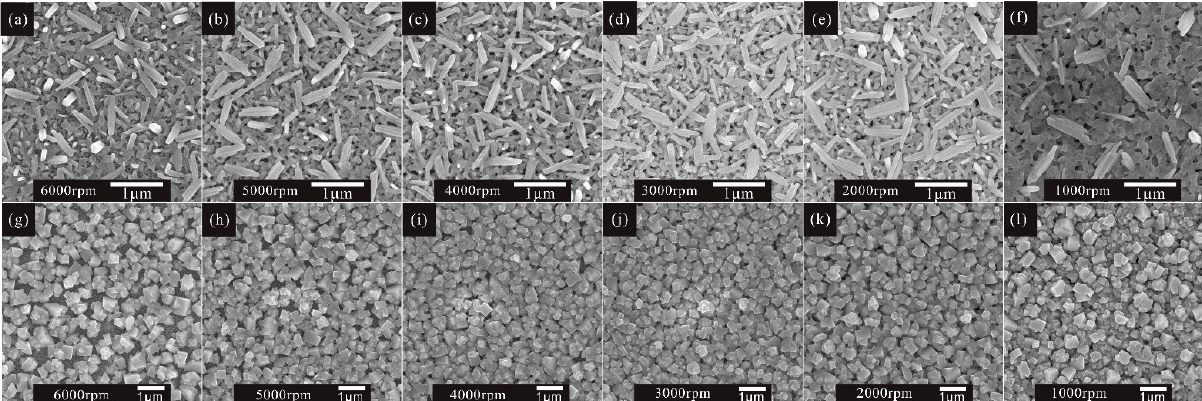
Figure 4. SEM top view images of PbI 2 films prepared under different spin-coating speeds from ( a – f ) 6000 r.p.m. to 1000 r.p.m., and corresponding MAPbI 3 films ( g – l ),